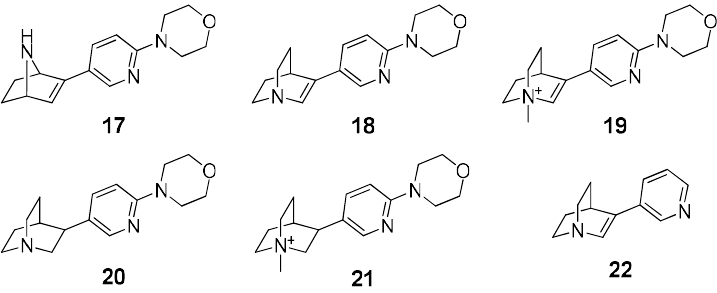
Figure 2. Structures of the five ligands selected through the virtual screening (VS) study (compounds 17 – 21 ) performed by Grazioso and co-workers, together with the reference compound ( 22